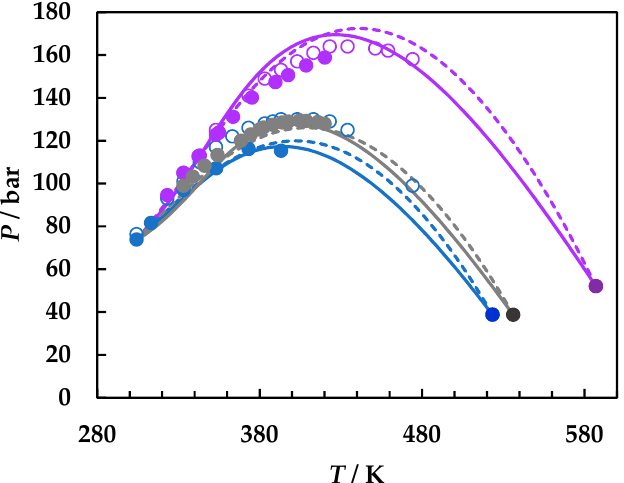
Figure 3. P – T fluid phase diagrams for carbon dioxide (1) + ethyl acetate (2), + 1,2-dimethoxyethane (2), and + 1,4-dioxane (2) binary systems, detailing the LV critical curves. Symbols, literature data [22,49,50,52]; full lines, predictions by GEOS; dotted lines, predictions by PR EoS. CO 2 + ethyl acetate ( blue ); CO 2 + 1,2-dimethoxyethane ( gray ); CO 2 + 1,4-dioxane ( purple ). Figure 2a shows the liquid–liquid critical lines that intersect the three-phase liquid–